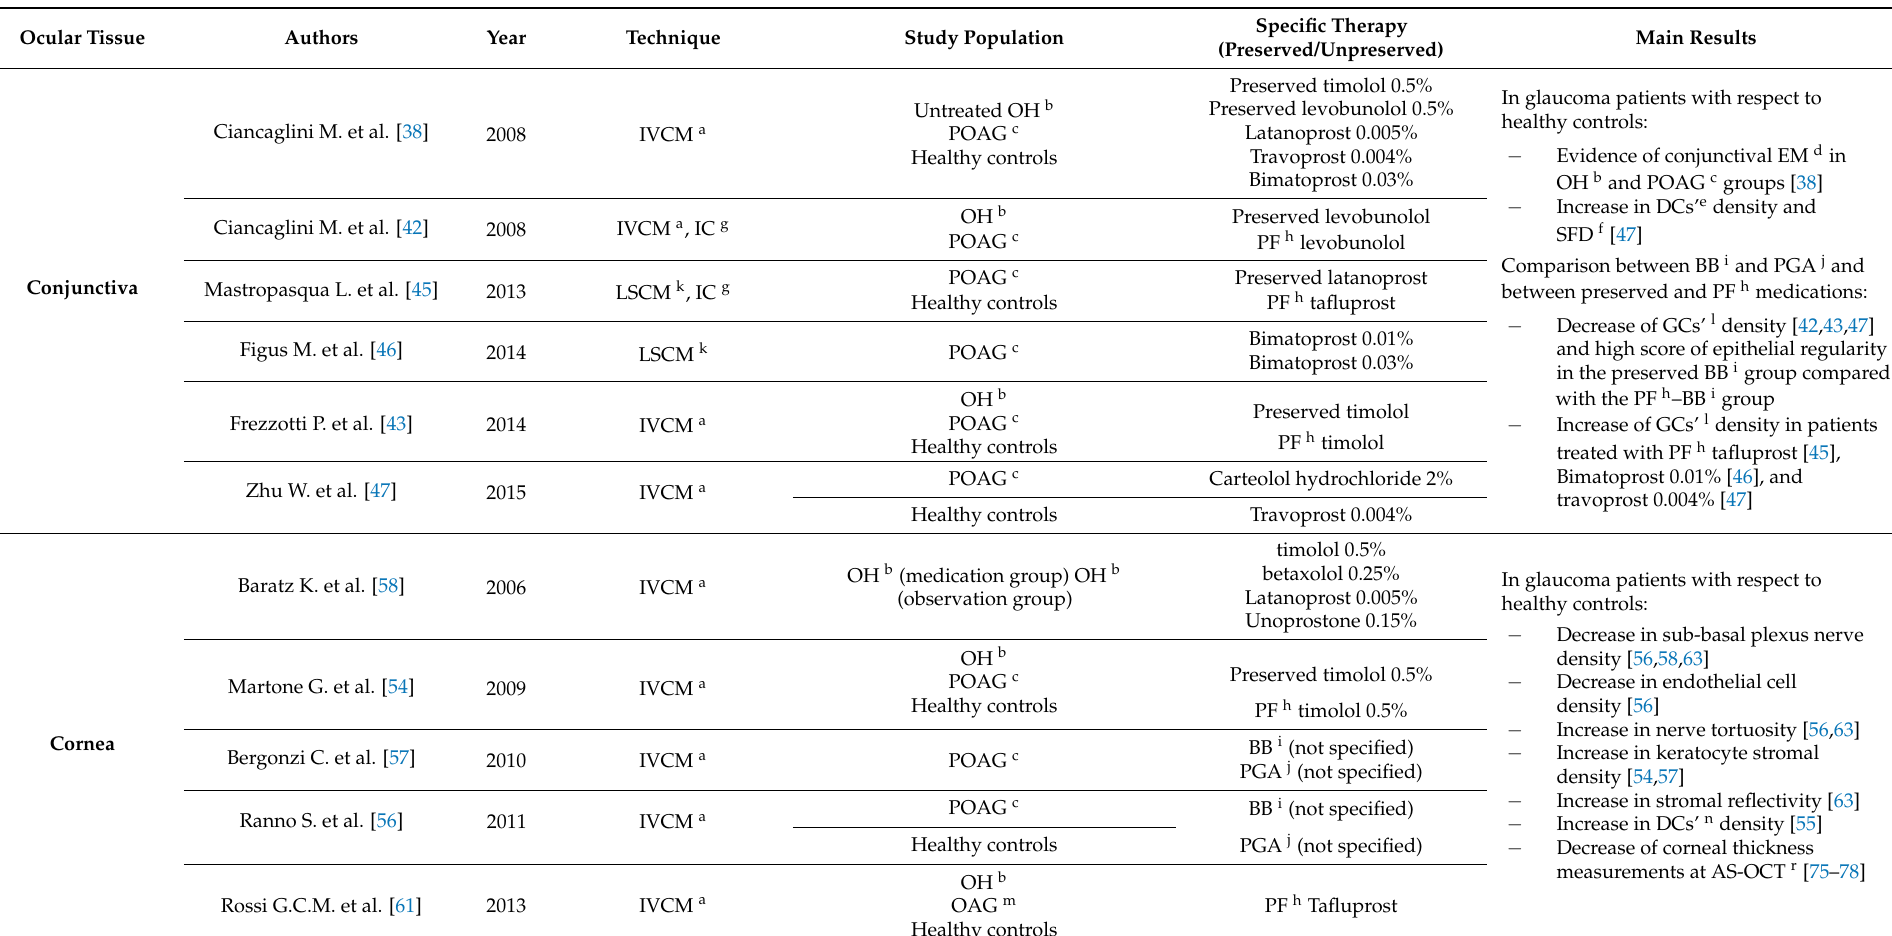
Table 1. Summary of clinical studies evaluating the main morphological changes induced by beta-blocker and prostaglandin analogue monotherapy on the ocular surface using IVCM and